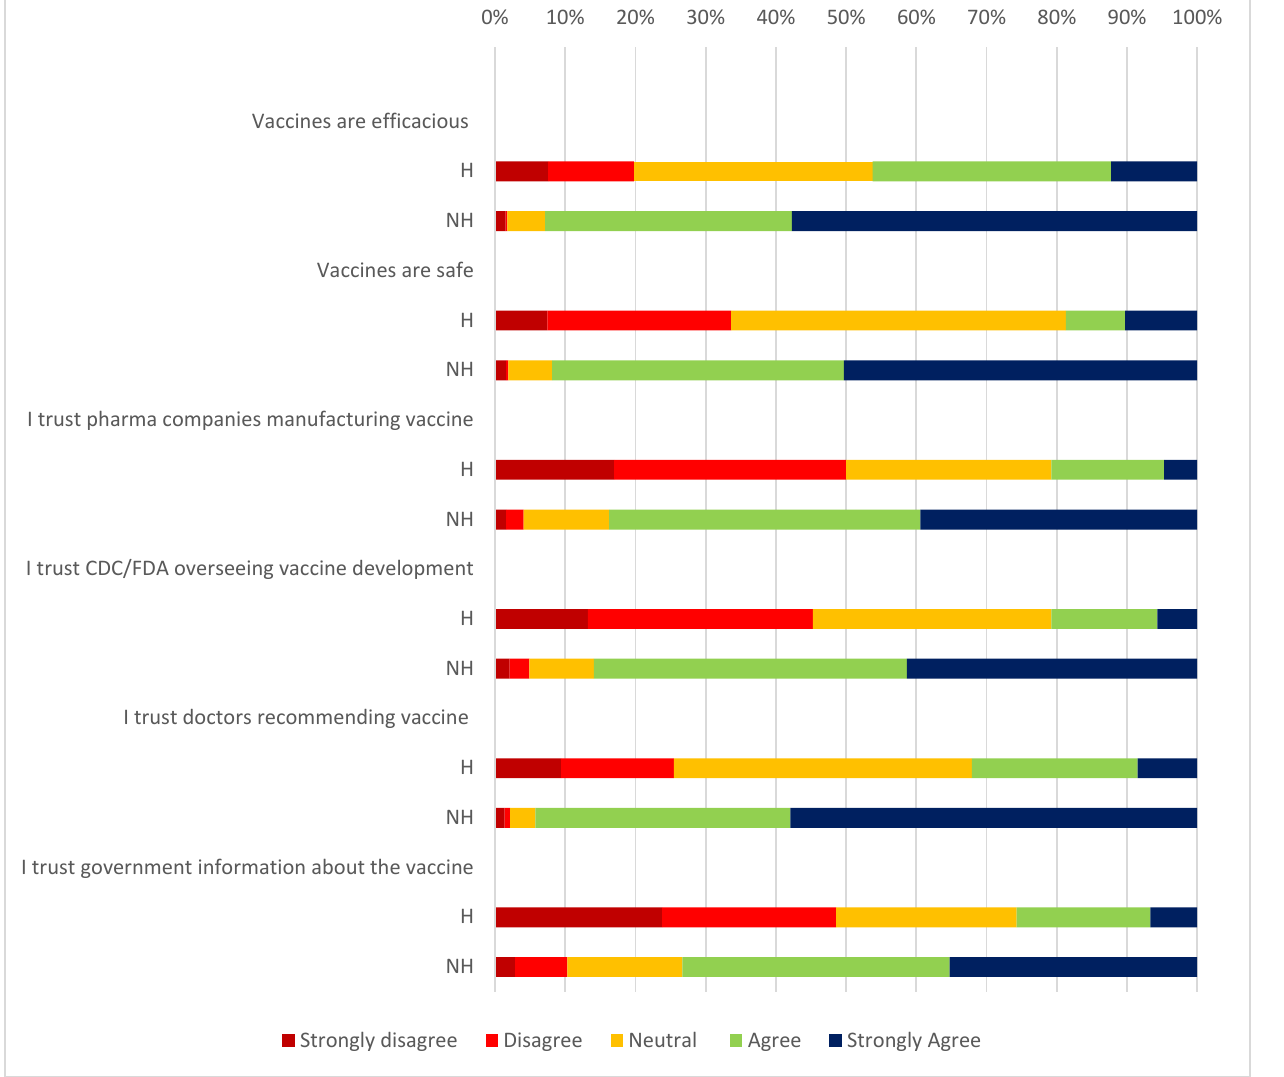
Figure 1. Attitudes related to COVID-19 vaccine. H — hesitant group, NH — non-hesitant group. Among the vaccine-hesitant group, lack of trust was reported in pharmaceutical companies (50%), government (48.6%), and regulatory authorities such as CDC/FDA (45.3%), with a much lower percentage reporting mistrust of doctors (25.4%). Those who were hesitant to receive COVID-19 vaccination noted concerns about vaccine safety (33.7%) and efficacy (19.8%) at higher rates than those in the non-hesitant group (concerns for safety − 1.9%, concerns for efficacy − 1.8%).